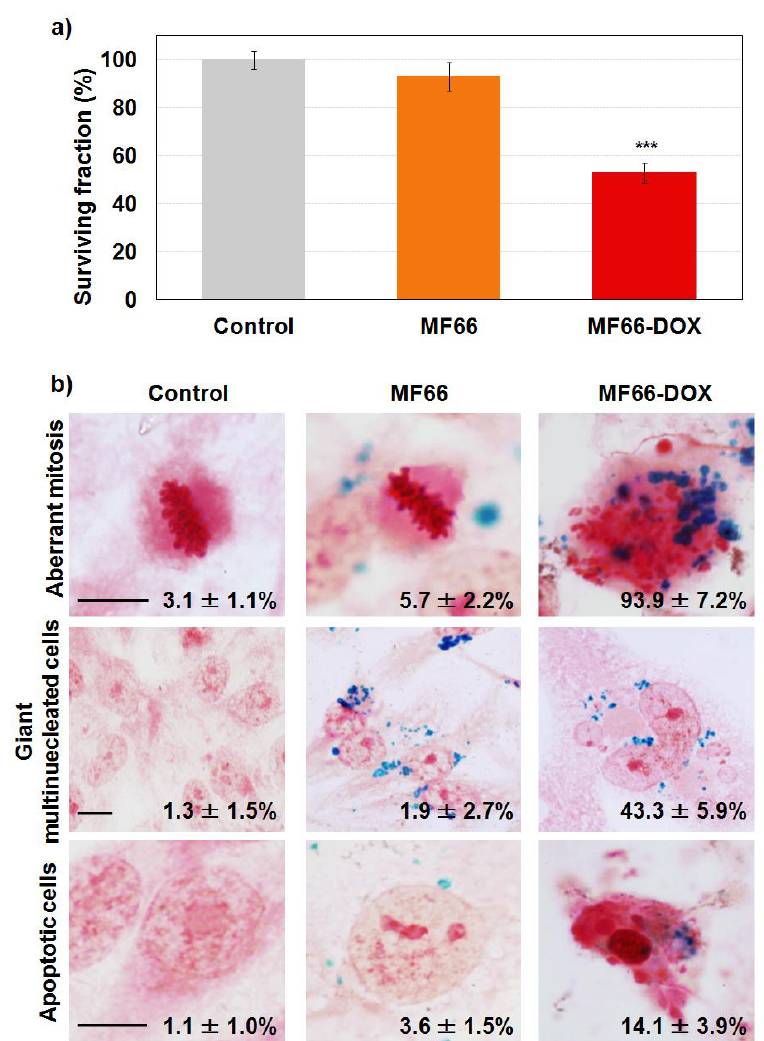
Figure 2. Evaluation of electrostatic nanoformulations in MDA-MB-231 cells 72 h after 24 h of incubation with the di ff erent treatments. ( a ) Cellular viability assessed after incubation with the di ff erent samples by AlamarBlue ® assay. ( b ) E ffi cient uptake and morphological alterations analysed by Prussian blue staining. Percentages included are the aberrant mitosis over the total number of mitosis and the number of giant multinucleated cells or apoptosis over the total number of cells. Scale bar: 10 µ